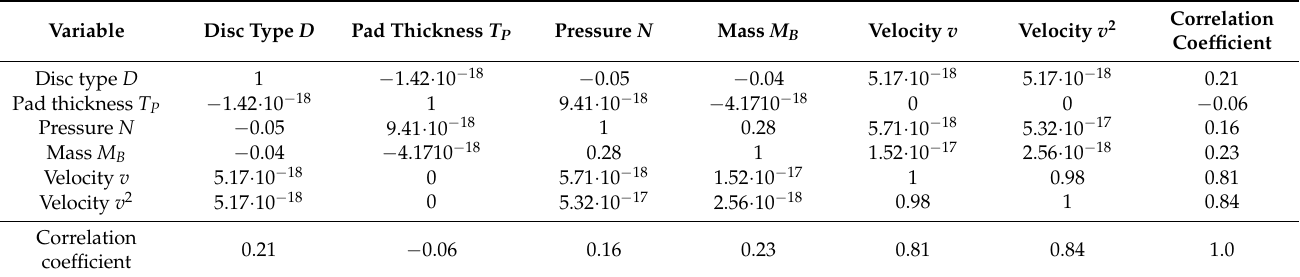
Table 5. Correlation